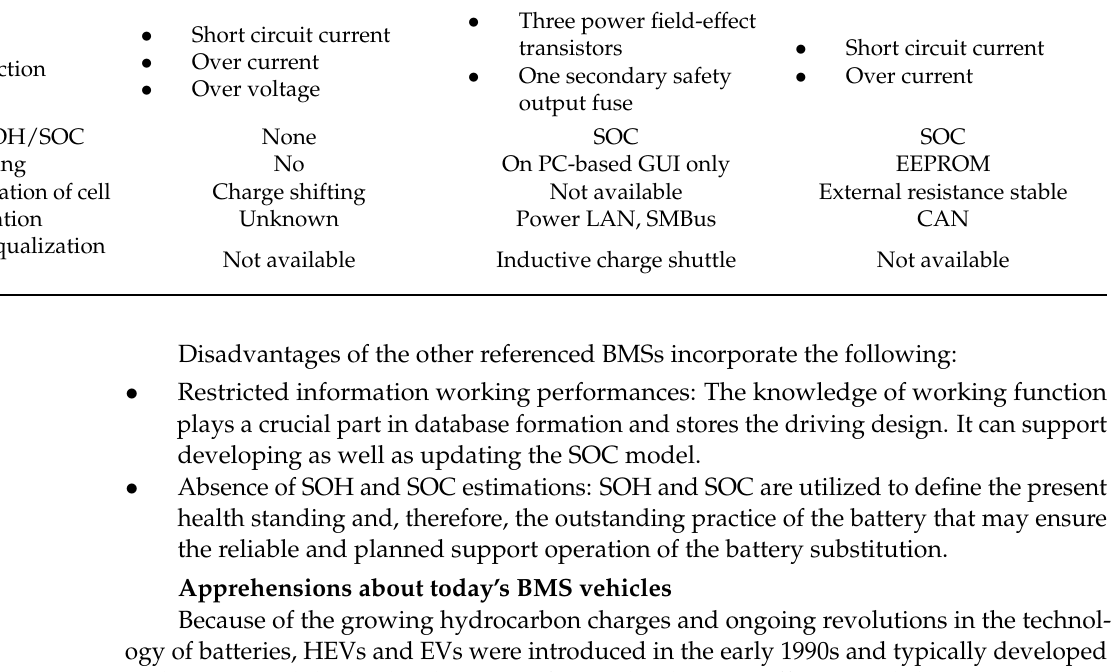
Table 4. Comparative analyses among various BMS products.